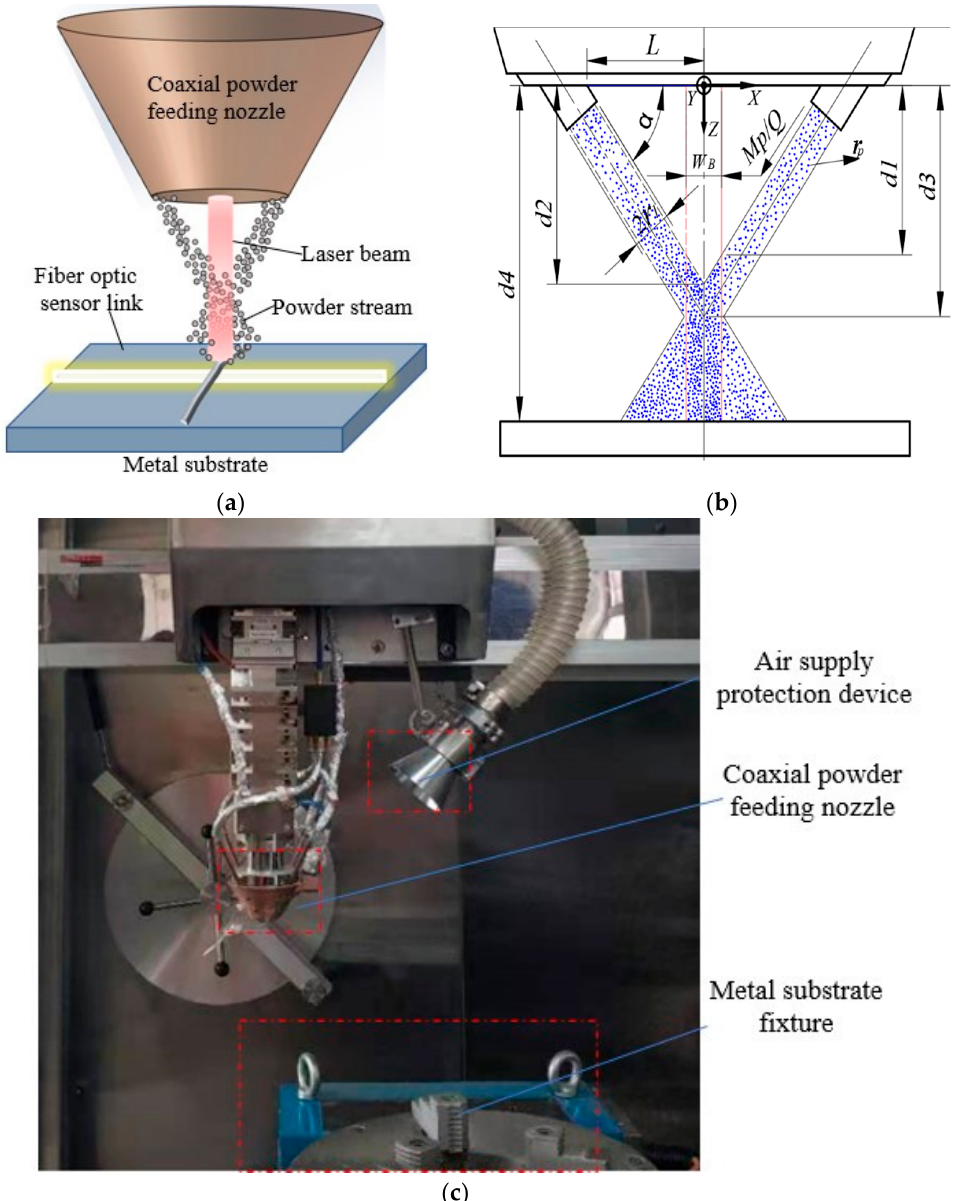
Figure 1. Structure diagram of laser cladding structure for optical fiber sensor: ( a ) Dimensional drawing, ( b ) Schematic diagram, ( c ) Physical image.